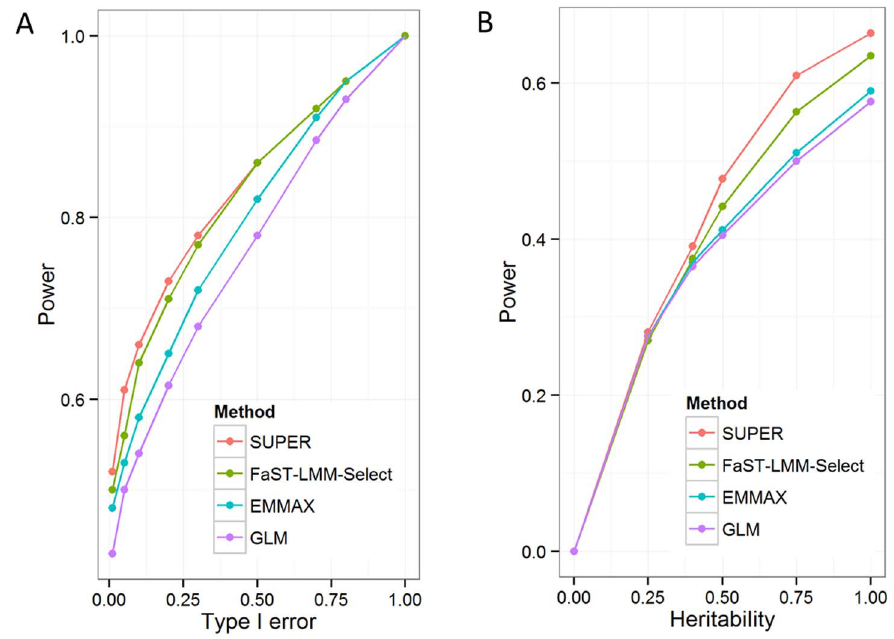
Figure 2. Statistical power under different ranges of type 1 error and heritability. A ) Statistical power was examined on a trait simulated from 27 causative mutations (QTNs) sampled from SNPs on chromosomes 1 to 9 in maize data. The SNPs on the last chromosome (10) were used to derive null distribution. Power was defined as the proportion of detected QTNs under type I error of 5%. A total of 100 replications was conducted for each method. The heritability of the trait was set to 75%. Four methods were examined: 1) SUPER; 2) EMMAX; 3) FaST-LMM-Select; and 4) General linear model (GLM). B ) Statistical power of four methods under different heritability levels. The four methods are SUPER, LMM-Selected, EMMAX and